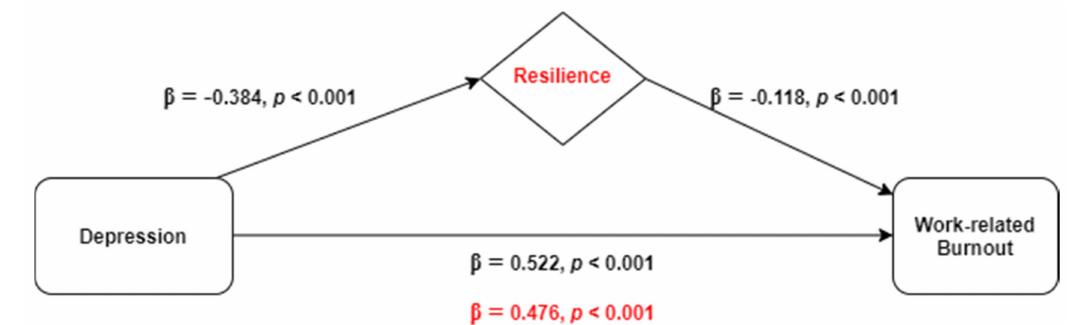
Figure 2. Representative scheme of the mediating role of resilience in the relationship between depression and work-related burnout. Changes in beta weights when the mediator is present are highlighted in red.